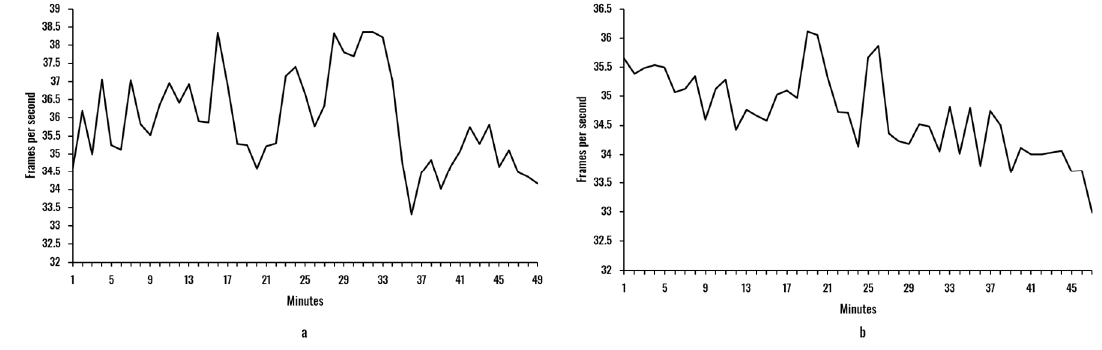
Figure 8. Mean of the fps per minute for the laptop hardware: ( a ) Haar model; ( b ) HOG model.